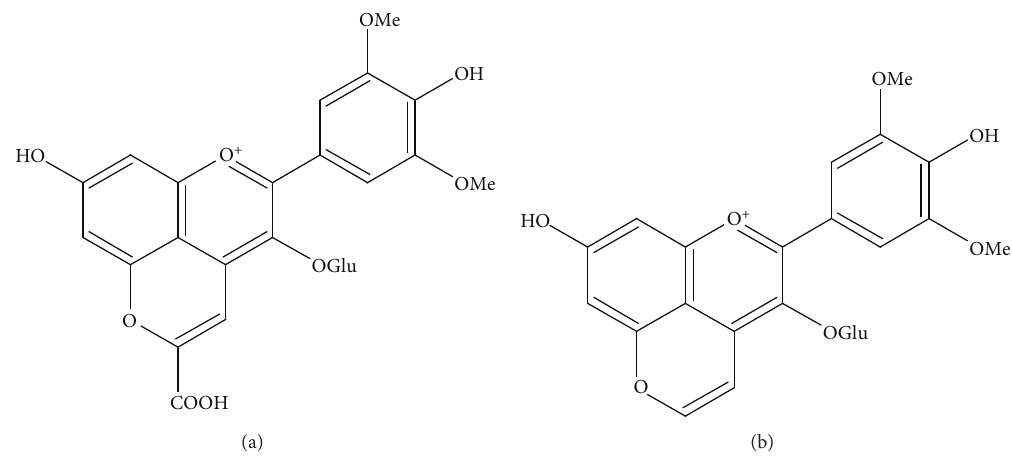
F 4: Chemical structures of vitisin A (a) and vitisin B (b) [8, 79].